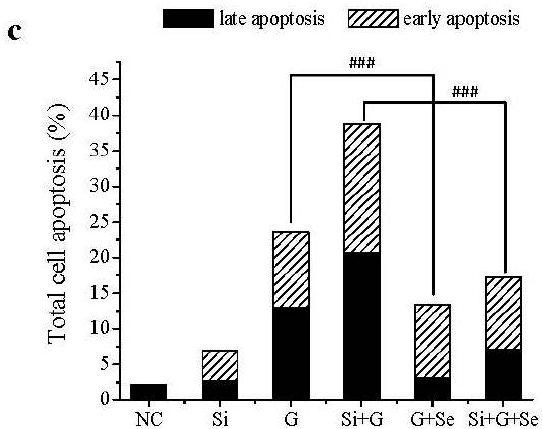
Figure 3. Effect of SelR gene knockdown and Na 2 SeO 3 on D -galactose-induced cell apoptosis. ( a ) hLE cell morphological changes in the indicated groups under the fluorescence microscopy after staining with Hoechst 33258 (200×); ( b ) Quantitative analysis of hLE cells apoptosis using flow cytometry by an Annexin-V-FITC apoptosis detection kit; ( c ) Total apoptosis cell percentage in the indicated groups. The black body and oblique line represent number of the late apoptosis cells (C2) and early apoptosis cells (C4). Data are the mean ± SD of at least three independent experiments. Arrows, examples of apoptotic cells. ### p < 0.001. NC: negative control cells; Si: cells with SelR siRNA transfection for 24 h; G: cells exposed to D -galactose (150 mM) for 36 h; Si+G: cells with SelR siRNA transfection followed by D -galactose exposure; G+Se: cells exposed to D -galactose (150 mM) and